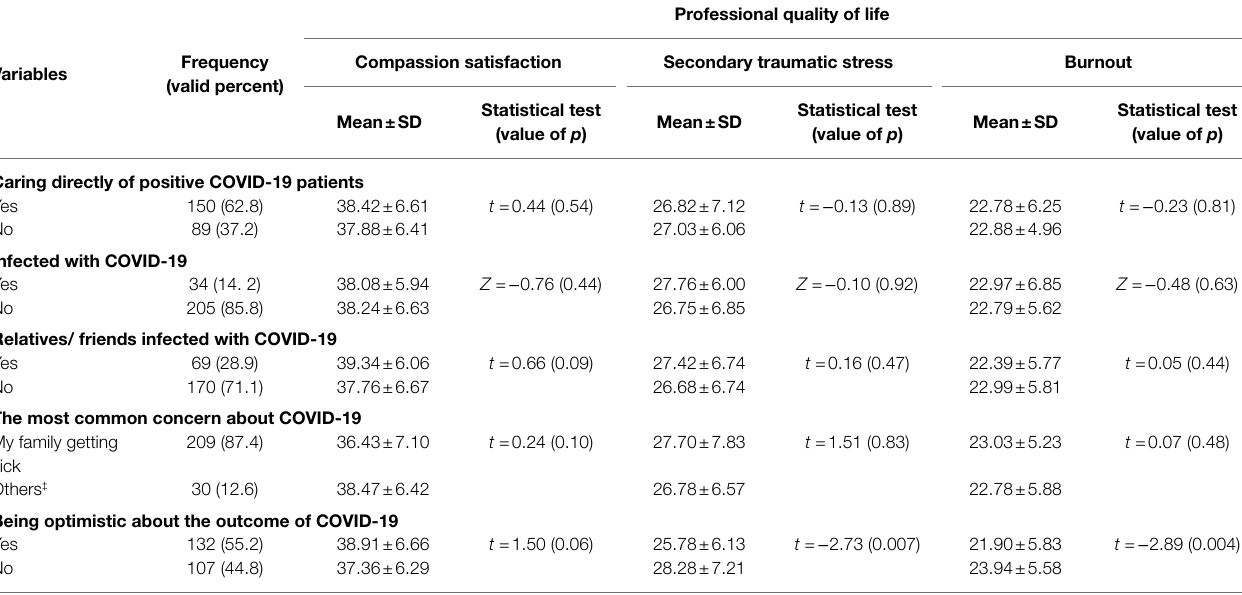
TABLE 2 | Information related to COVID-19 disease of the participants and their associations with professional quality of life ( n = 239).